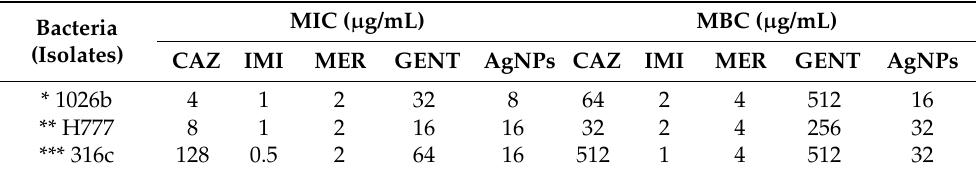
Table 1. Minimum inhibitory concentrations (MICs) and minimum bactericidal concentrations (MBCs) of antibiotics and AgNPs against B. pseudomallei in three clinical isolates (serial dilution plate count method). The data represent the average of three independent experiments which gave identical values. MIC ( µ g/mL) MBC ( µ g/mL) Bacteria (Isolates) CAZ IMI MER GENT AgNPs CAZ IMI MER